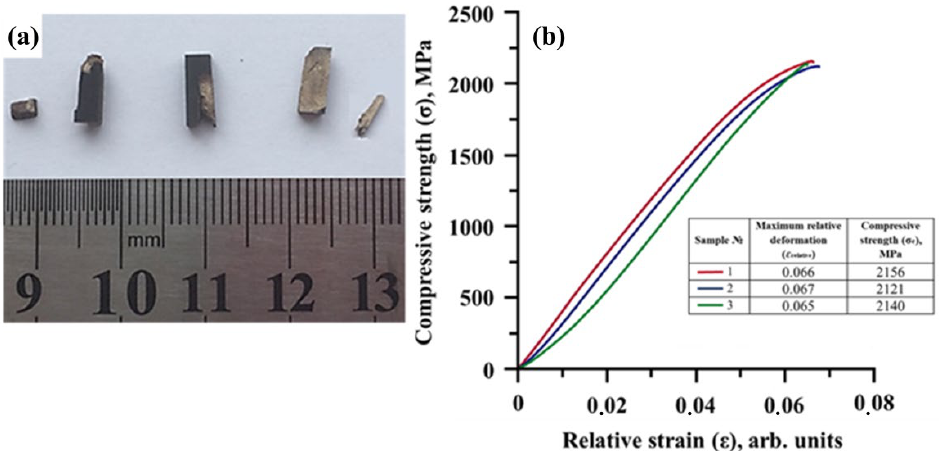
Figure 5. Appearance of NiTi-TiB 2 samples after the compressive tests ( a ), a stress–deformation Figure 5. Appeara nce of NiTi -TiB 2 samples after the compressive tests ( a ), a stress– deformation di- diagram obtained during the compressive test ( b ). agram obtained during the compressive test ( b ).